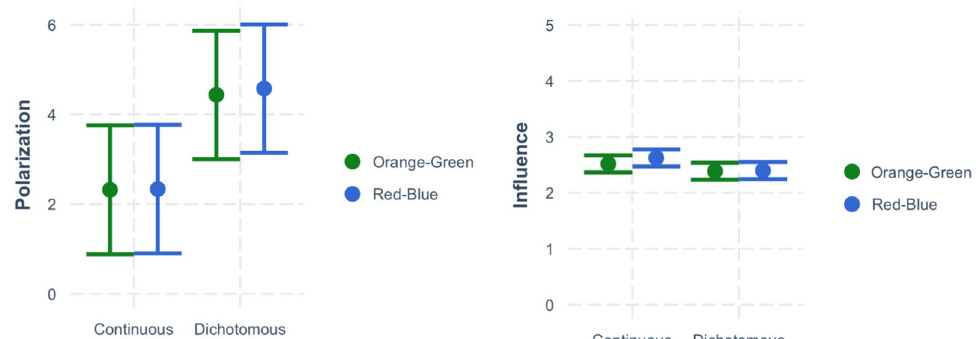
Fig. 6 Study 2 results. The effect of Gradient Steps (continuous versus dichotomous) on the polarization of participants’ voting estimates (left) and how influential they thought individual votes would be (right). This effect was not moderated by whether the maps used a red/blue or orange/ green hue